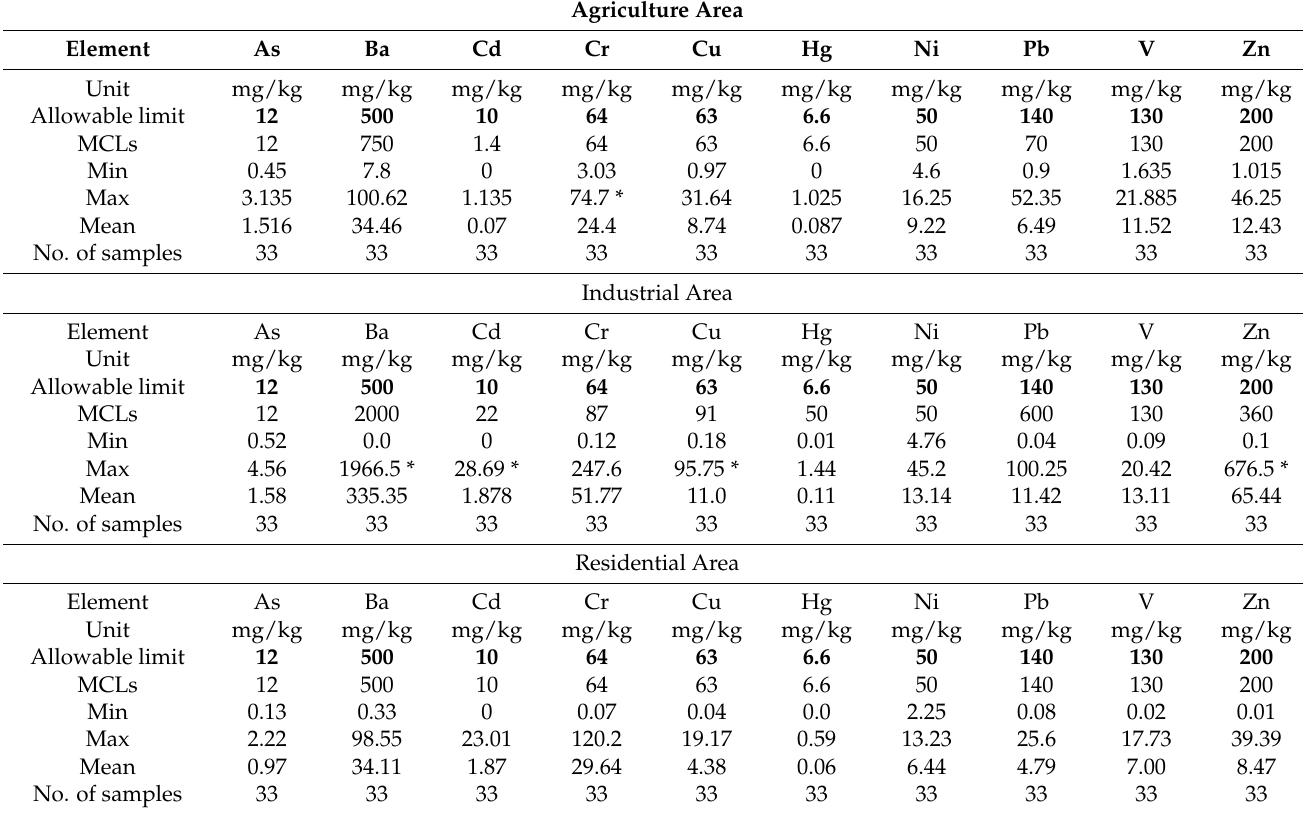
Table 1. Concentration of trace metals in the Dammam